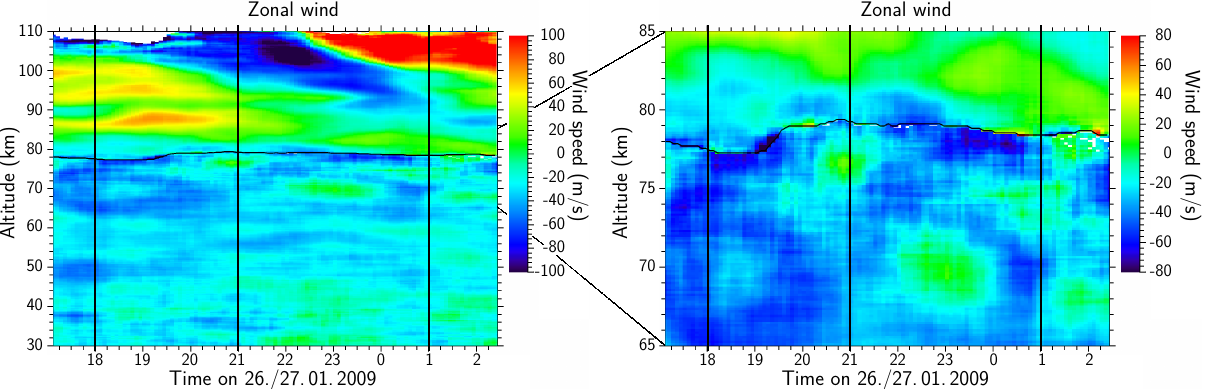
Fig. 10. Zonal wind speed on 26/27 January measured by RMR and Na lidar with the NWT. In the height range of overlap (roughly 78– 85km) and above, only wind from Na lidar is shown. Left panel: complete altitude range between 30 and 110km. Right panel: close-up between 65 and 85km altitude, highlighting the transition from RMR lidar to Na lidar data at 77–79km (indicated by black line). Vertical black lines indicate profiles of zonal wind speed shown in Fig. 11.